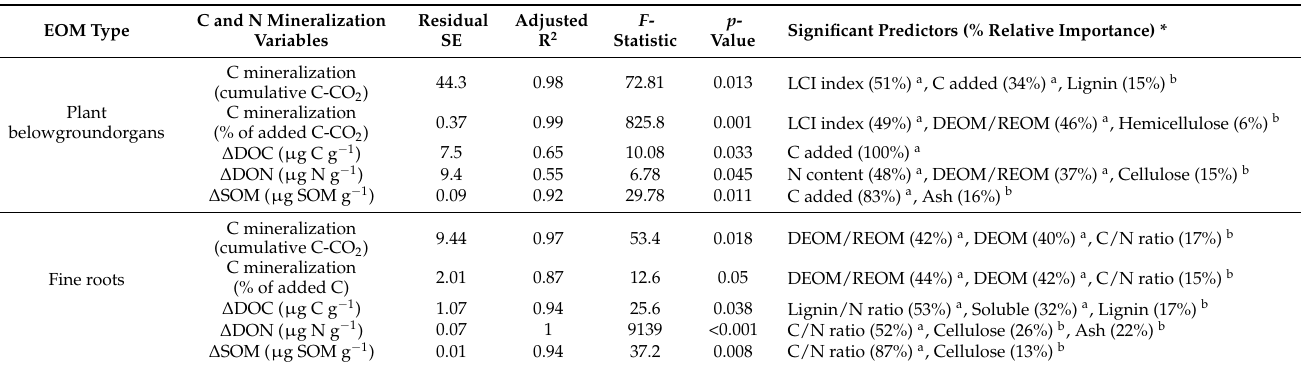
Table 4. Summary statistics of the multiple regression models obtained for exogenous organic matter